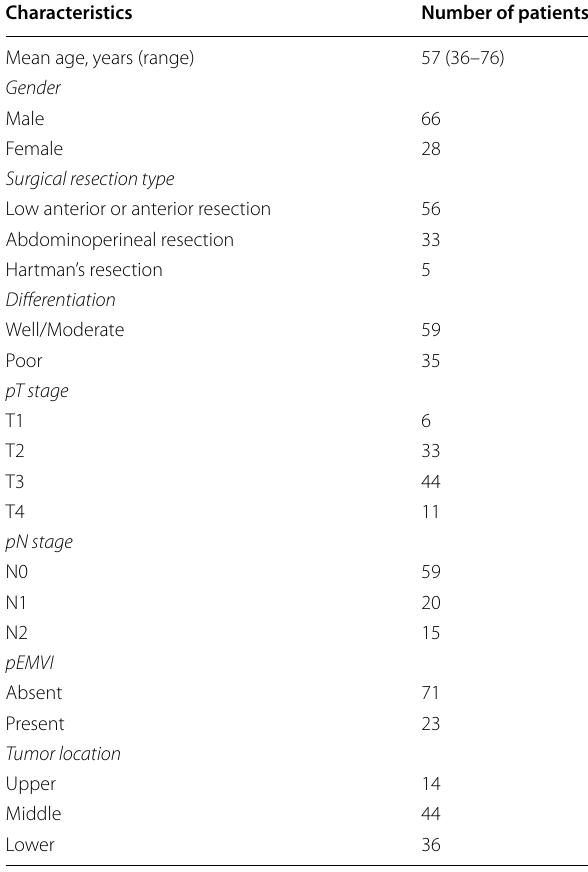
Table 2 Clinical